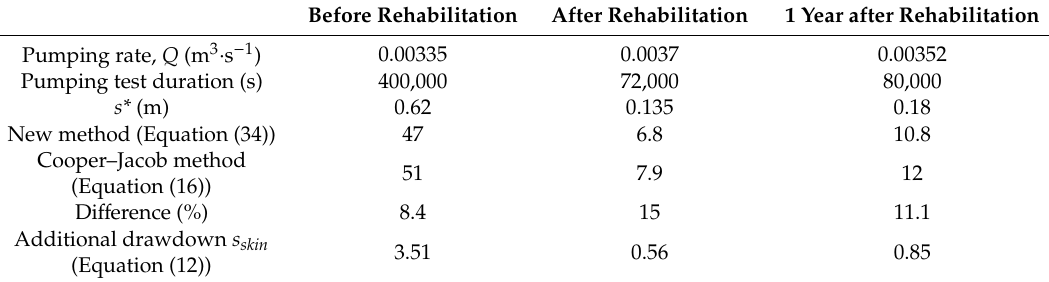
Table 4. Results of evaluating the skin factor and additional drawdown—S-V